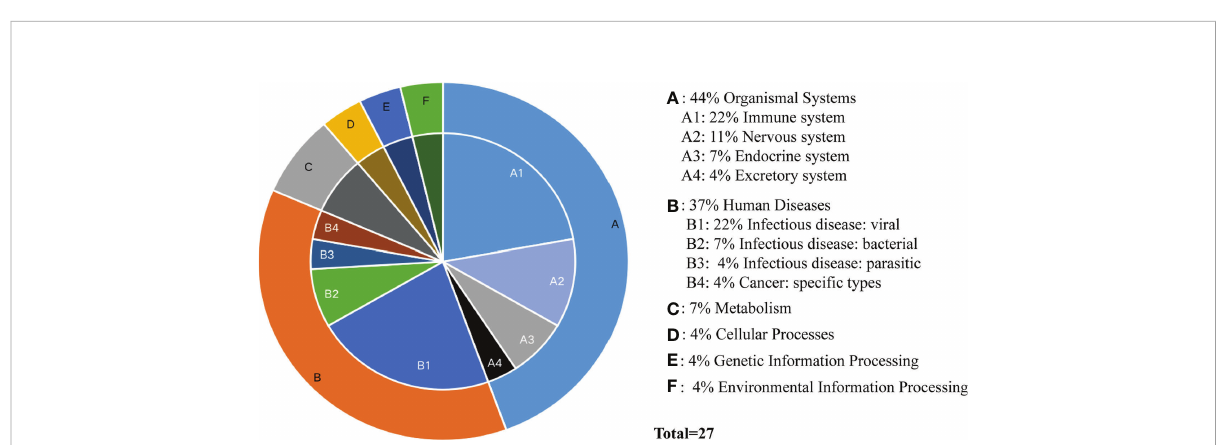
FIGURE 5 Classi fi cation of target pathways in MS patients treated with Fingolimod or IFN- b . (A) Organismal Systems; (B) Human Diseases; (C) Metabolism; (D) Cellular Processes; (E) Genetic Information Processing; (F) Environmental Information Processing. “ Fatty acid metabolism ” is not classi fi ed